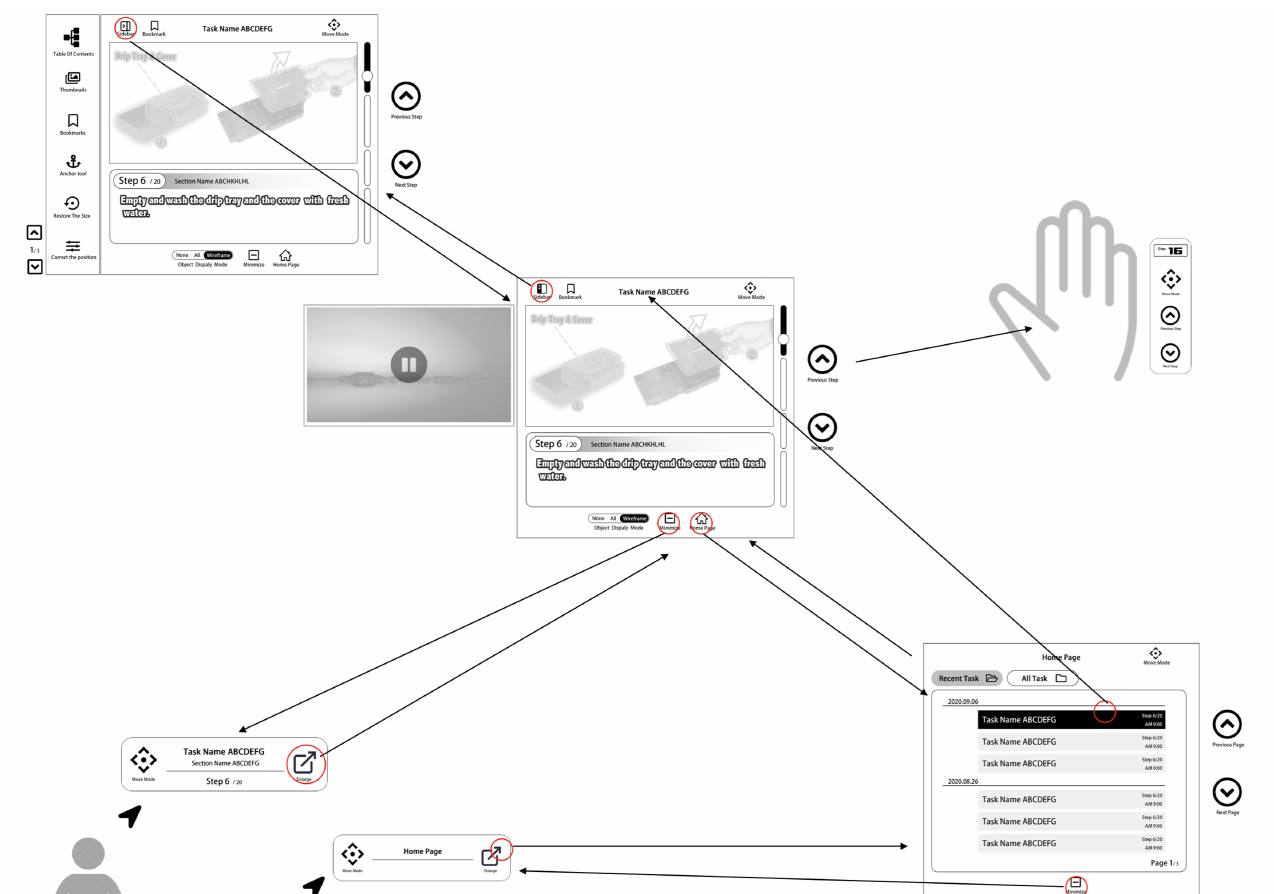
Figure 10. Example of main-panel interaction